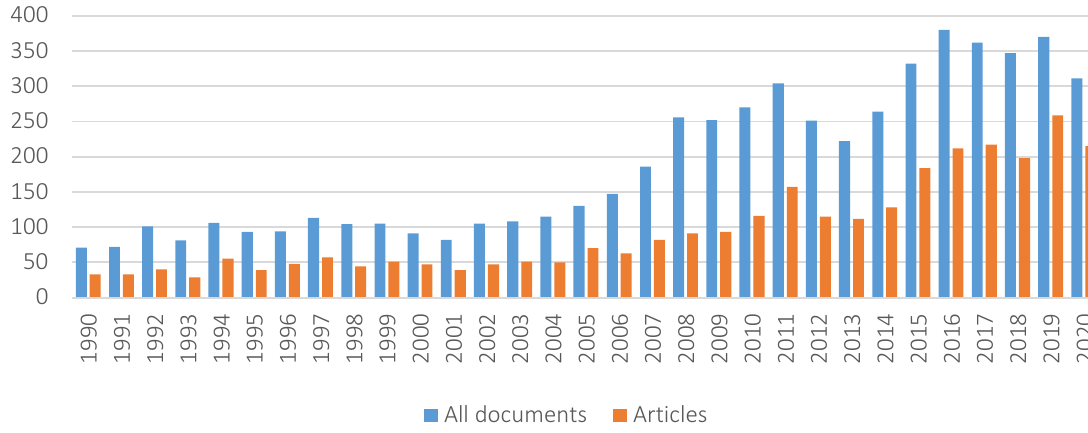
Figure 4. Distribution of the number of documents by